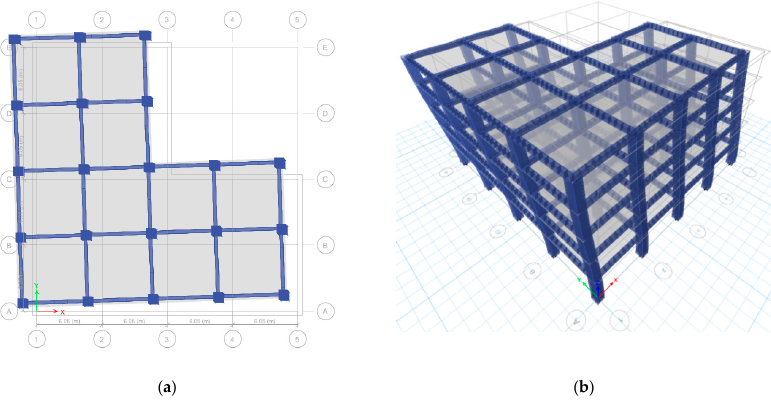
Figure 5. The 1st mode shape for T 1 = 0.471 s: ( a ) plane view and ( b ) 3D view.